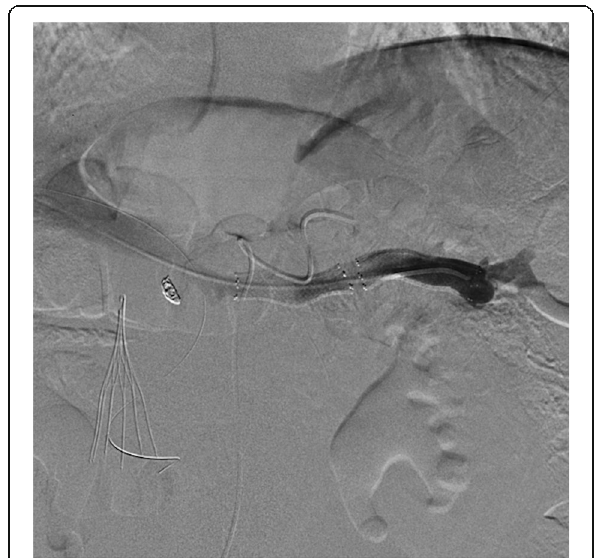
Fig. 2 Digital subtraction venography of the splenic vein after deployment of splenic stents shows increased splenic venous patency with resolution of splenoportal